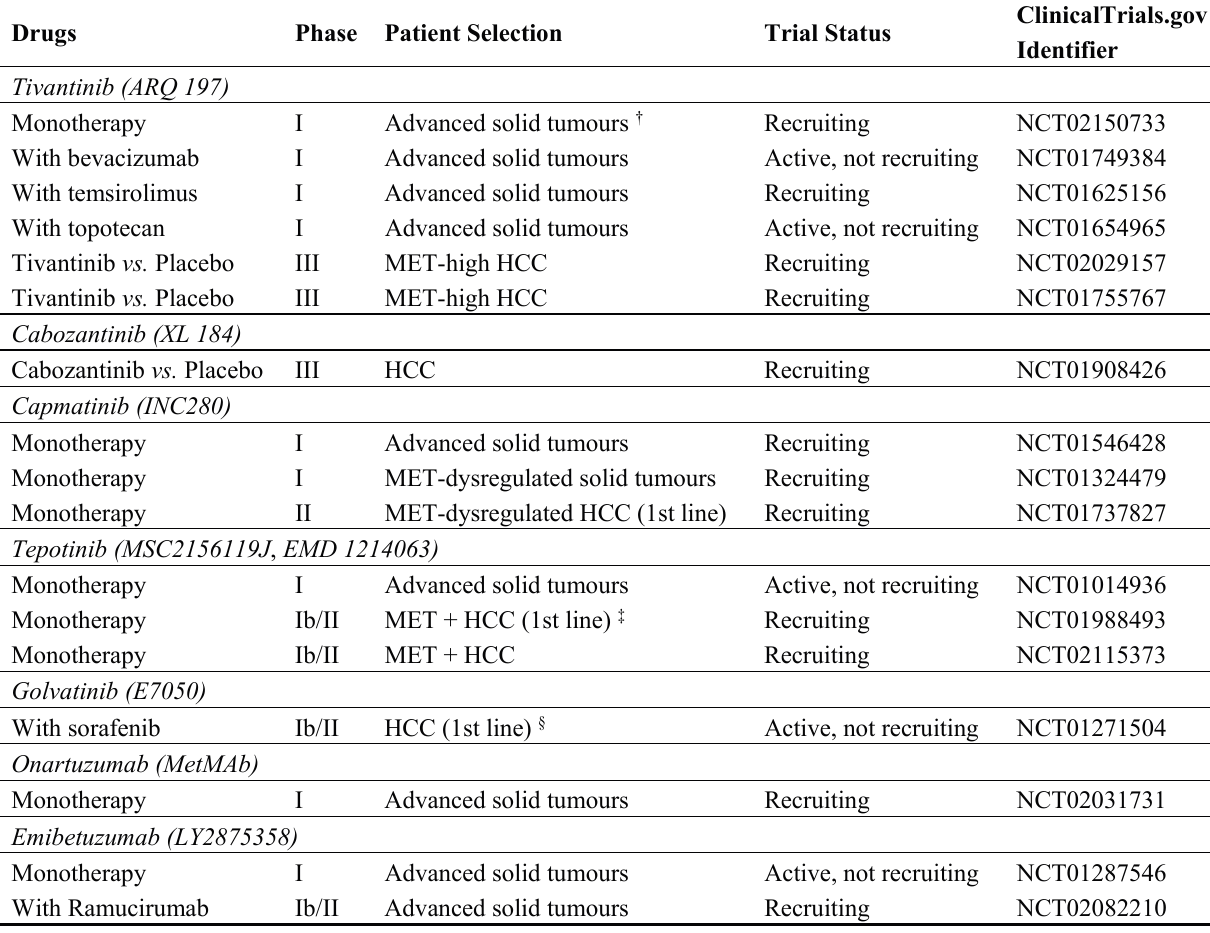
Table 2. Selected Active Clinical Trials on c-MET inhibitors for